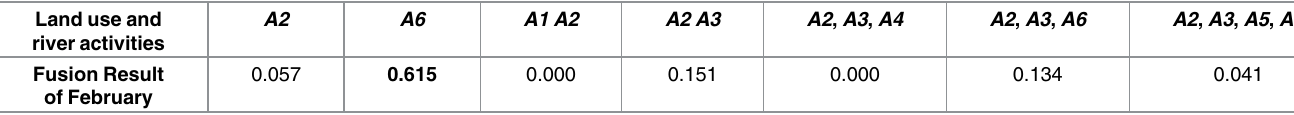
Table 7. Fusion results of February by using the proposed method.